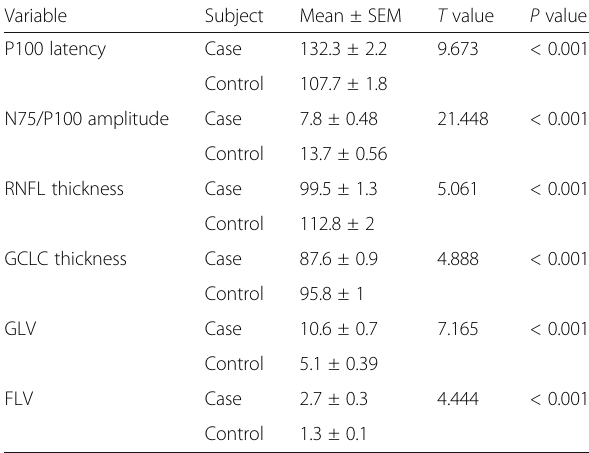
Table 2 VEP and OCT measurements for patients with MS and healthy controls